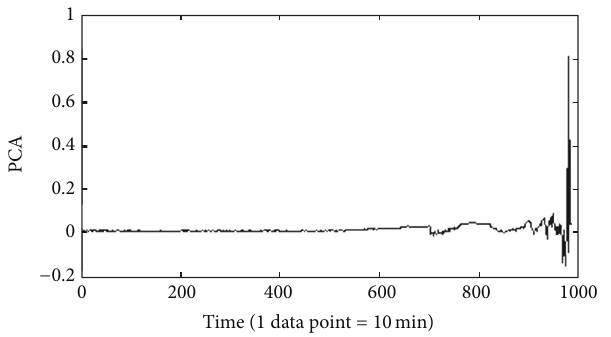
Figure 8: The first principal component of test bearing based on PCA method.